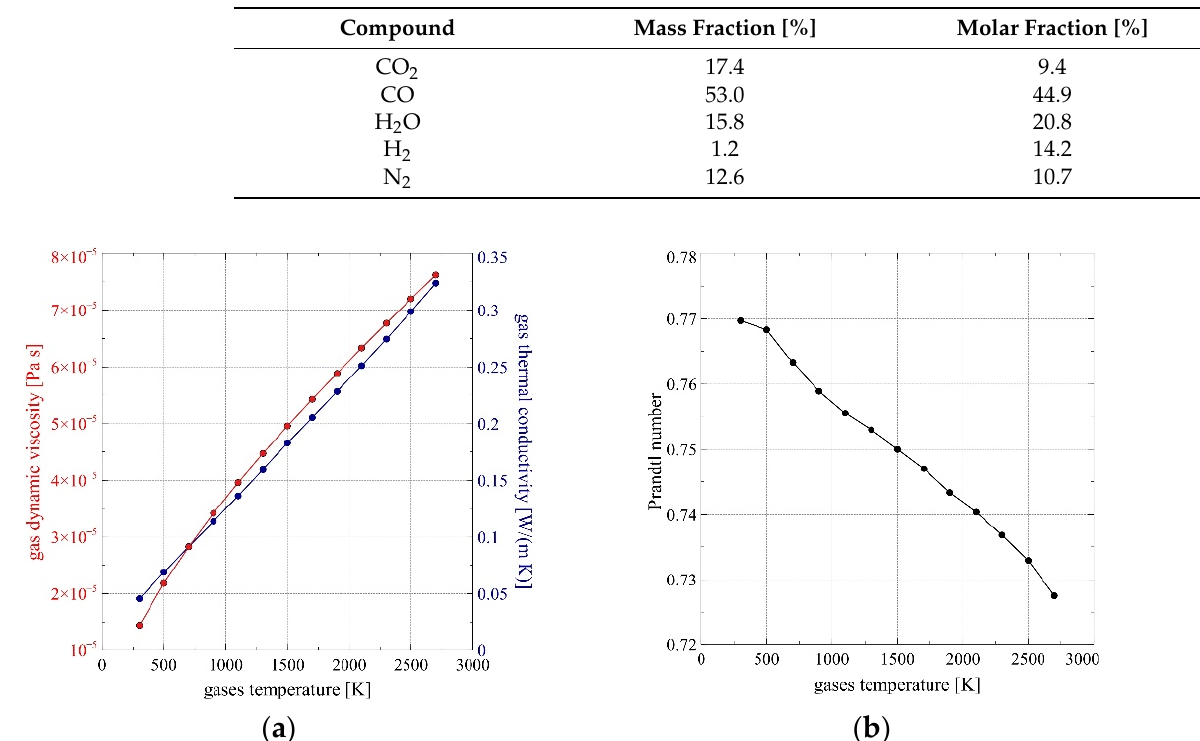
Figure 8. Diffusive transport coefficients (a) and Prandtl number (b) of propellant gases as a function of temperature.